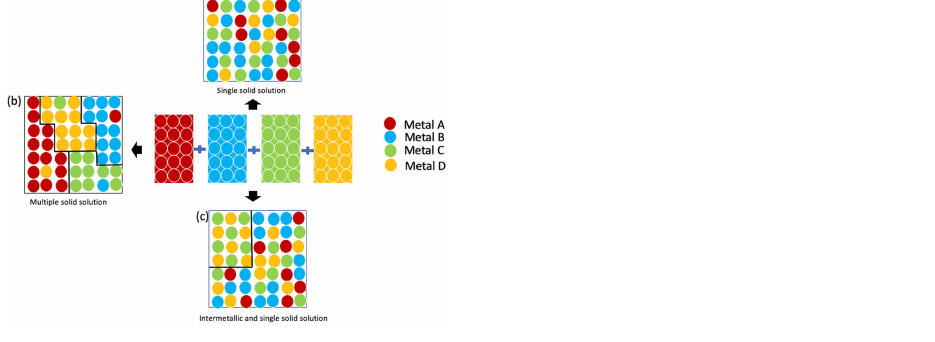
Figure 1. Possible reactions that might take place when equal amounts of four distinct elements are mixed. ( a ) is singke solid solution, ( b ) is multiple solid solution and ( c ) is intermetallic and single solid